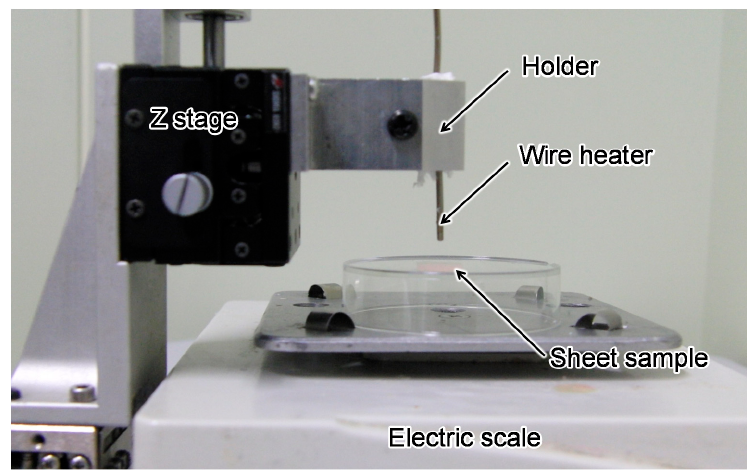
Figure 7. Experimental setup of local heating of sheet sample.